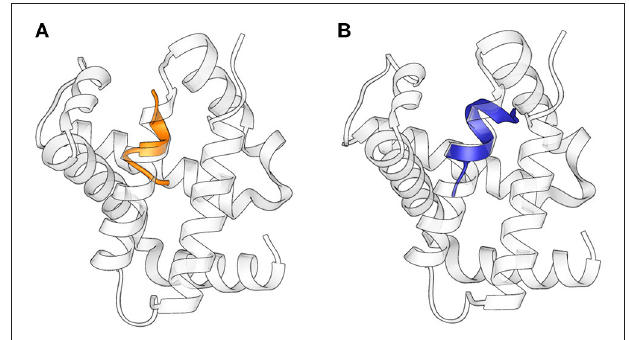
FIGURE 4 | Superimposition of the structures of ( A) Pepcan-9 (orange) and (B) Pepcan-12 (blue) on the α -chain of hemoglobin (PDB code 2DN1).